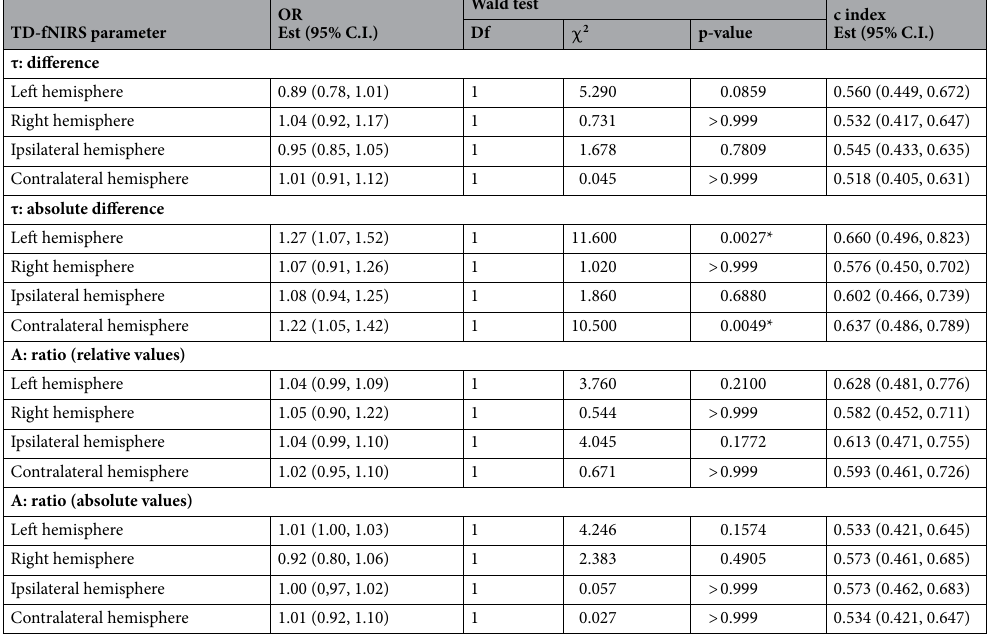
Table 4. Association and discriminant ability of pre-defined functions of TD-fNIRS parameters. Results obtained by estimating 16 distinct logistic models including a single independent variable, i.e. the differences τ O2Hb − τ HHb and the ratios A O2Hb /A HHb . Each p-value and each confidence interval was adjusted for the multiplicity of tests, using the Bonferroni rule. Column 1: TD-fNIRS parameters ( A peak amplitude, τ peak latency). Column 2: estimated OR ( Est estimates). Column 3: tests of association between parameters and pathological classification of eyes ( Df degrees of freedom. χ 2 Chi-square statistics. *p < 0.05). Column 4: estimates of the concordance index